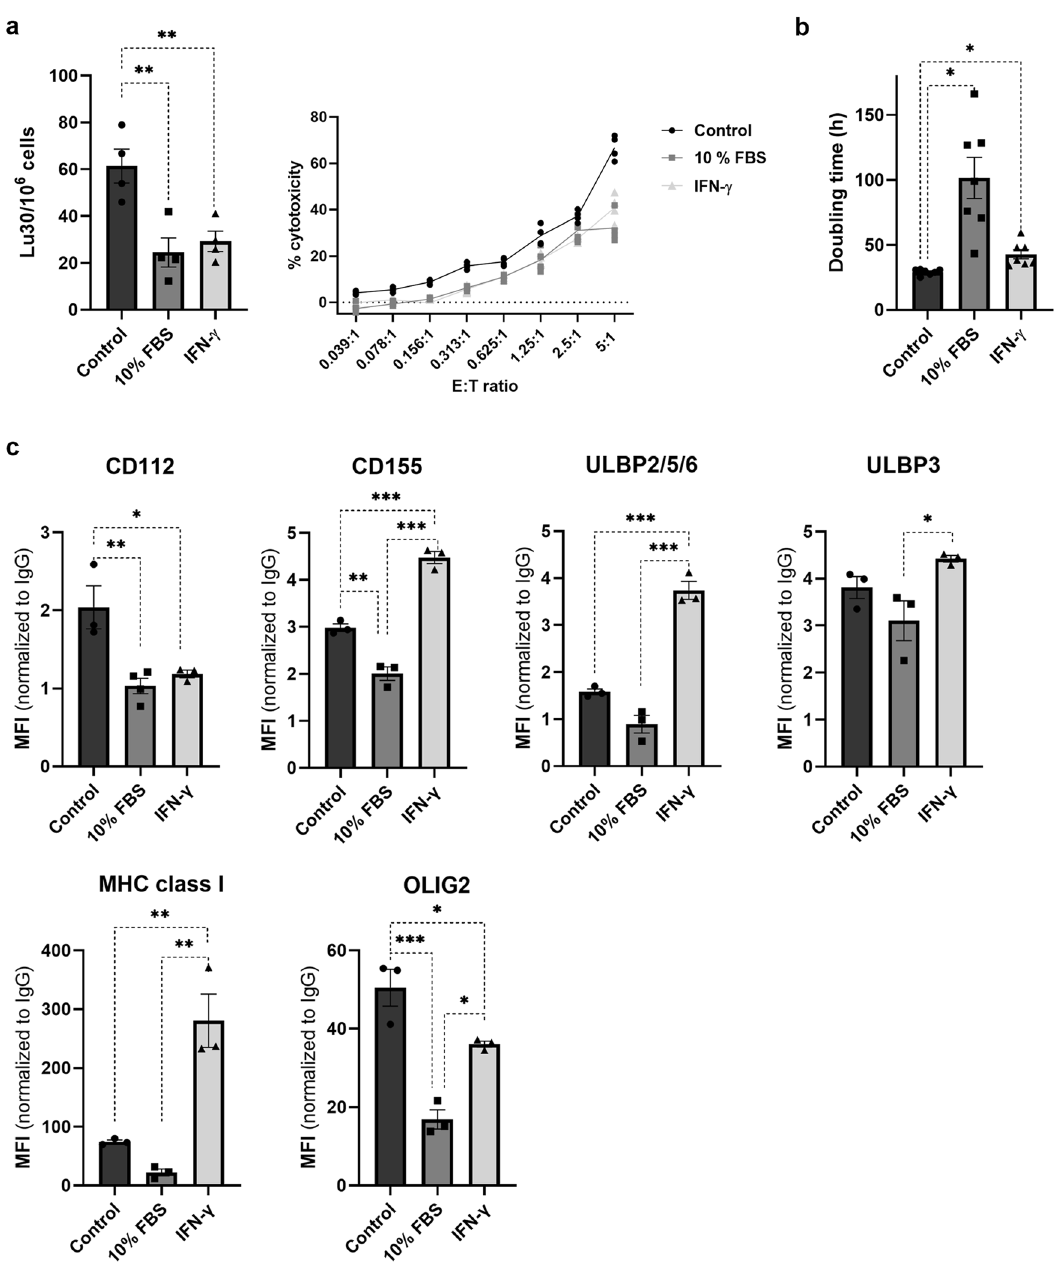
Fig. 7 Super-charged NK cell-mediated lysis was impaired after GSLC differentiation with 10% FBS and exposure to IFN- γ . Differentiation and IFN- γ treatment decreased GSLC proliferation and altered levels of ligands for NK cell activating and inhibitory receptors as well as decreased levels of OLIG2. After NCH421k cells were treated with cell culture medium containing 10% FBS (dark gray bars) for 7 days or 30 ng of recombinant human IFN- γ (light gray bars) for 48 h, cytotoxicity assay using calcein AM release ( a ), doubling time analysis ( b ) and protein expression analysis using immunostaining and fl ow cytometry ( c ) were performed. Neurobasal GSLC culture media was used as control (black bars). Data are presented as means ± SEM, data points represent independent biological replicates, n ≥